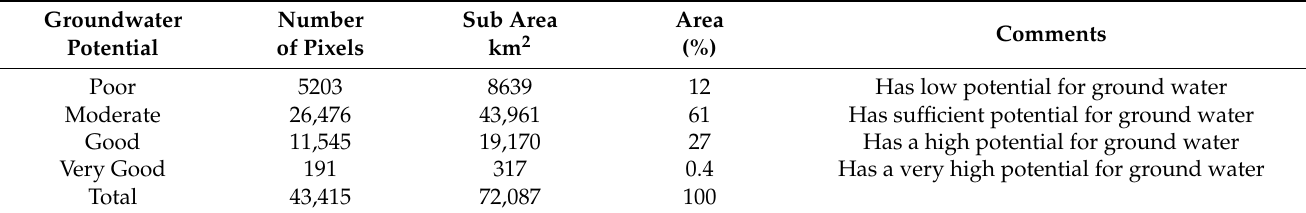
Table 4. Ground water potential zonal areas.